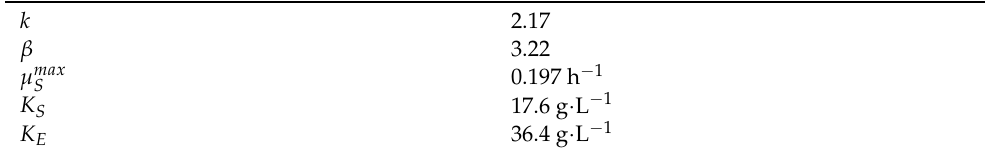
Table 7. Parameters for the second step S → E + CO 2